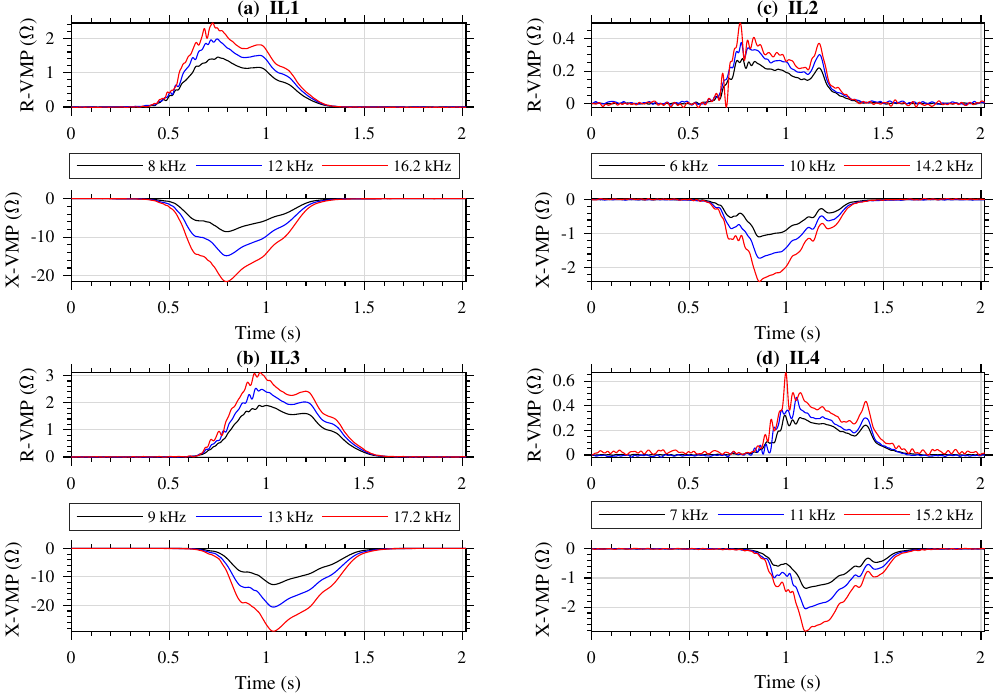
Figure 10. VMPs of a passenger car shown in Figure 7c, further description the same as in Figure